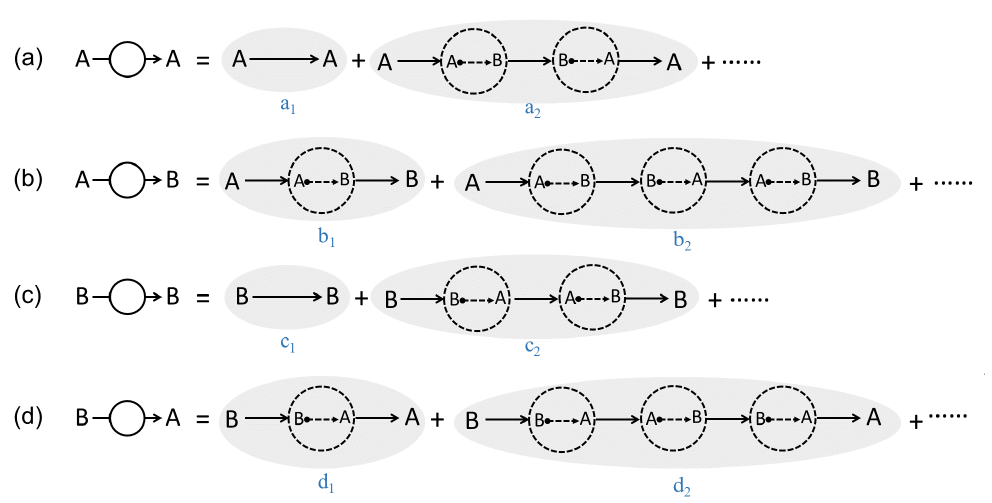
Figure 1. Diffusion–reaction–diffusion (DRD) diagrams of four processes related with the A/B binary reaction–diffusion system. In the diagram, the solid arrow indicates diffusion, and the dotted arrow means chemical reaction. ( a , c ) The diffusions of A or B component from r to r + ∆ r within a given amount of time ∆ τ actually consists of a bunch of possible DRD diagrams in the A/B reaction system. The reactions A → B ( b ) and B → A ( d ) also consist of numerous DRD diagrams. Note that a given diagram actually corresponds to an ensemble of